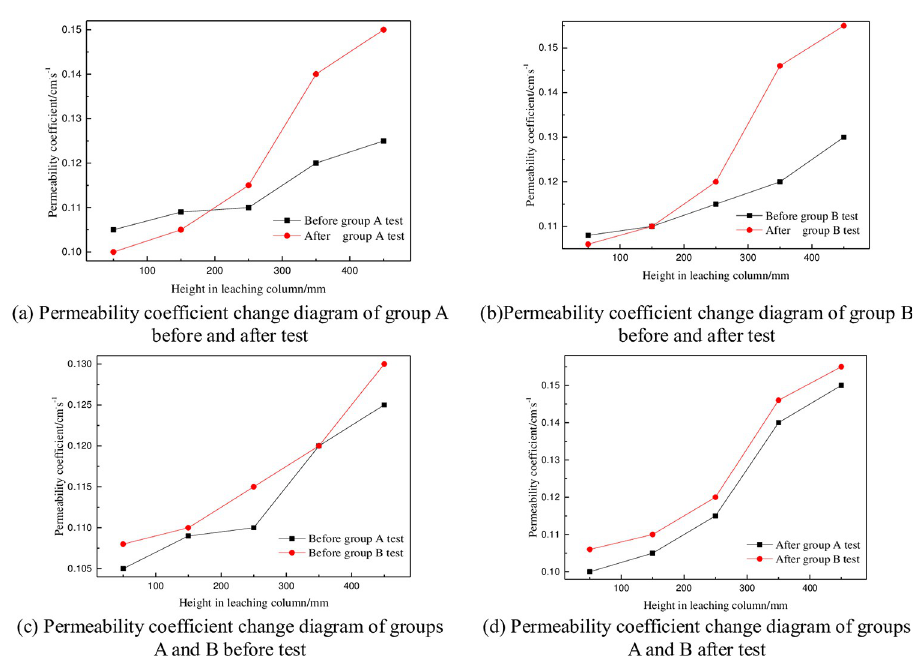
Fig 8. Change diagrams for permeability coefficients in the column immersion test. (a) Permeability coefficient change diagram of group A before and after test. (b)Permeability coefficient change diagram of group B before and after test. (c) Permeability coefficient change diagram of groups A and B before test. (d) Permeability coefficient change diagram of groups A and B after test.